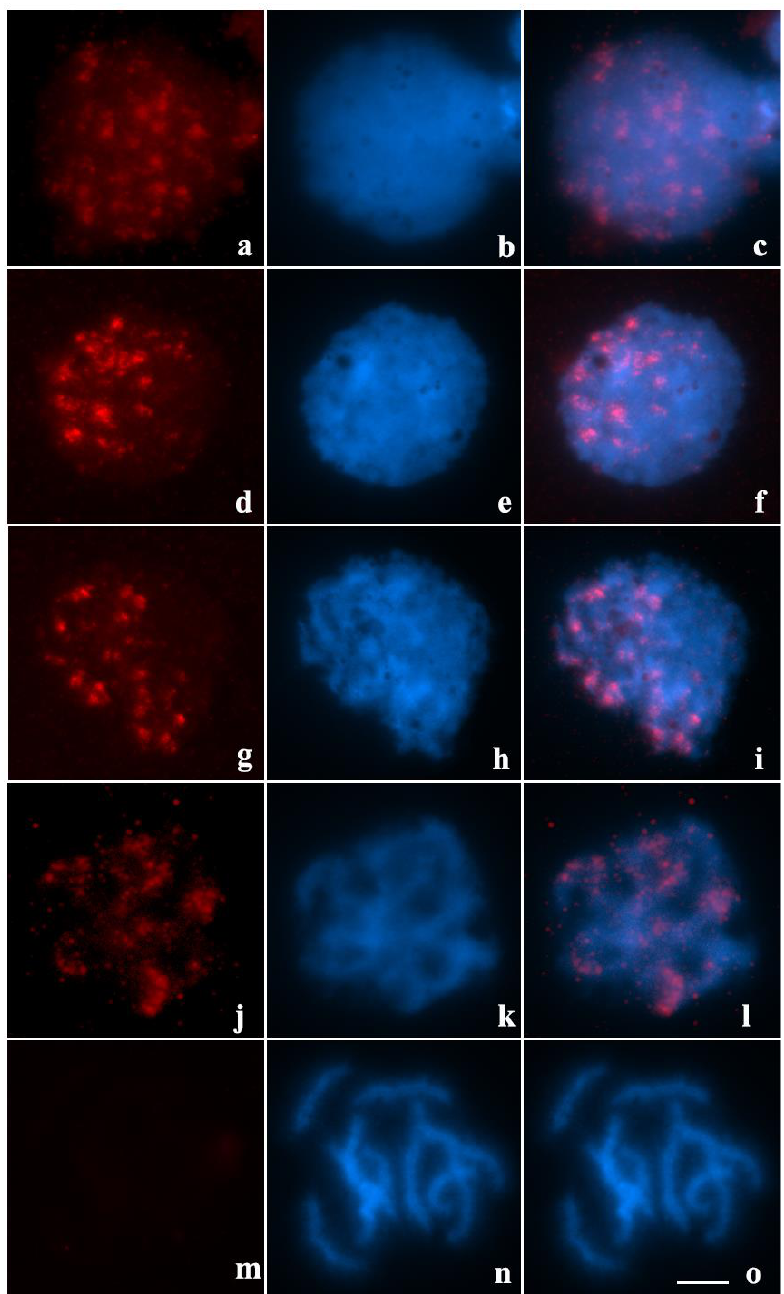
Figure 3. Visualization of DSBs through immunodetection of γ H2AX in prophase I of T. maranhensis (blue: DAPI; red: γ H2AX): ( a – c ) leptotene; ( d – f ) early zygotene; ( g – i ) late zygotene; ( j – l ) early/intermediate pachytene; ( m – o ) late pachytene. Bar: 10µm.